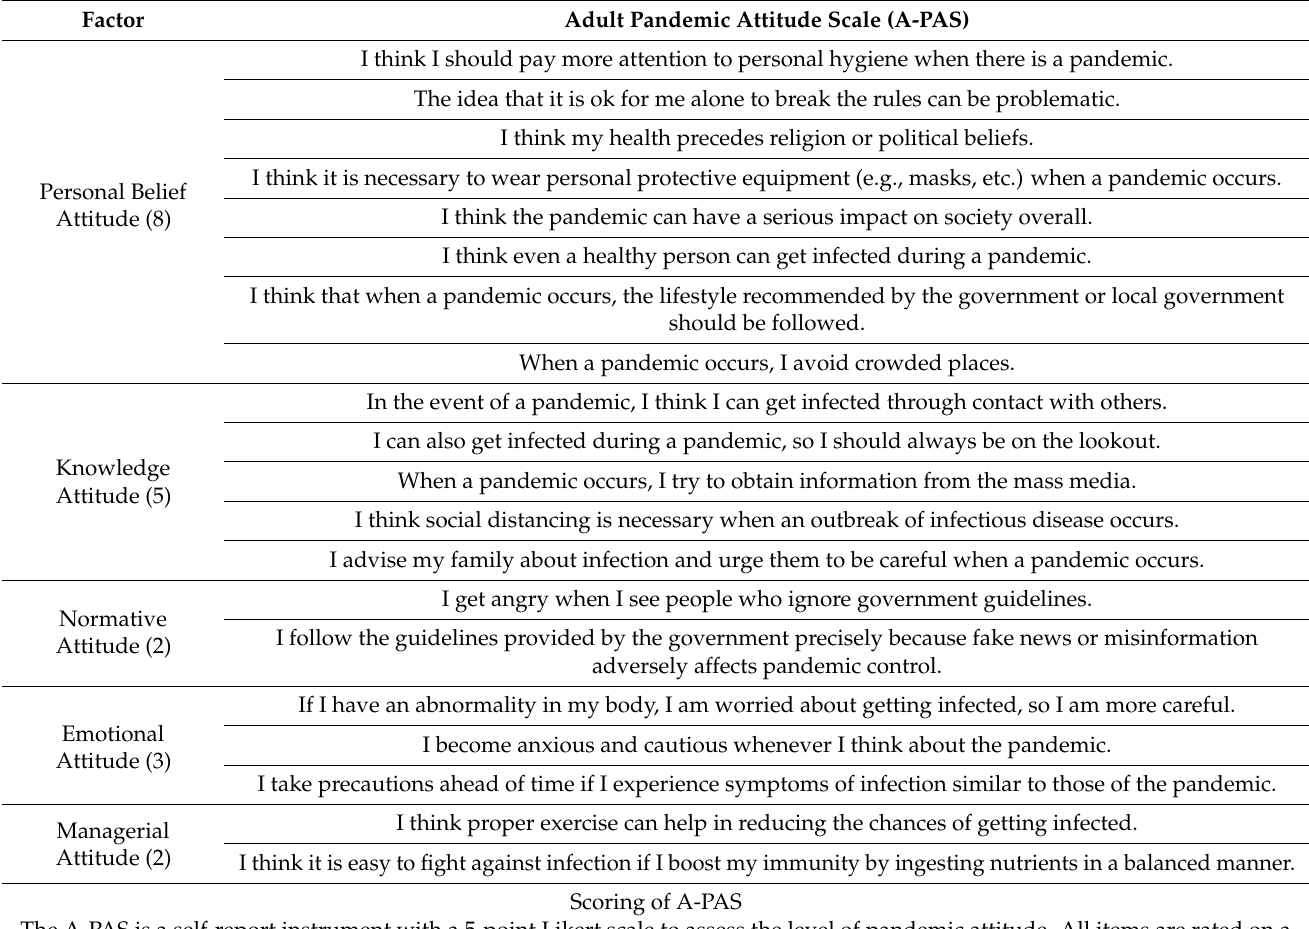
Table 7. Adult Pandemic Attitude Scale